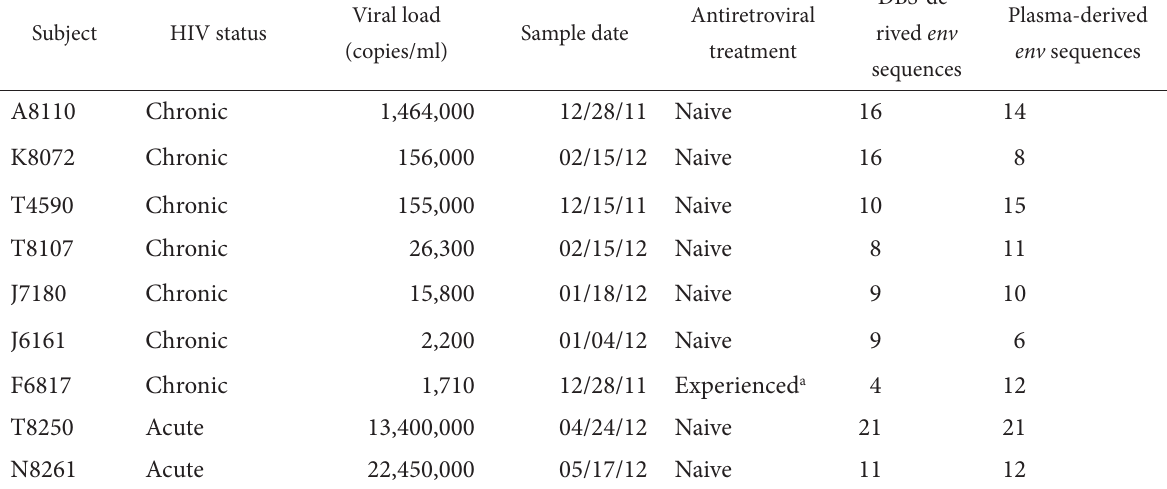
Table 1. Study subjects characteristics and number of SGA-derived env sequences. a. Subject was previous- ly on ART, but had been off ART for > 3 months prior to 12/28/11